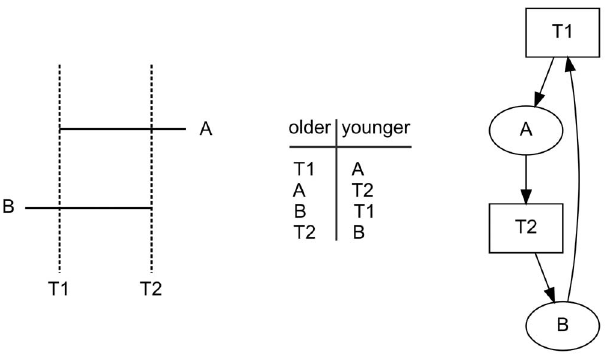
Figure 4. Example of a cycle. Left , map showing trails T1 and T2 with agricultural walls A and B ; middle , table of the chronological relationships shown on the map; right , picture of a directed graph of the chronological relations, where ovals represent agricultural walls, rectangles represent trails, and arcs point from an older feature to a younger one.